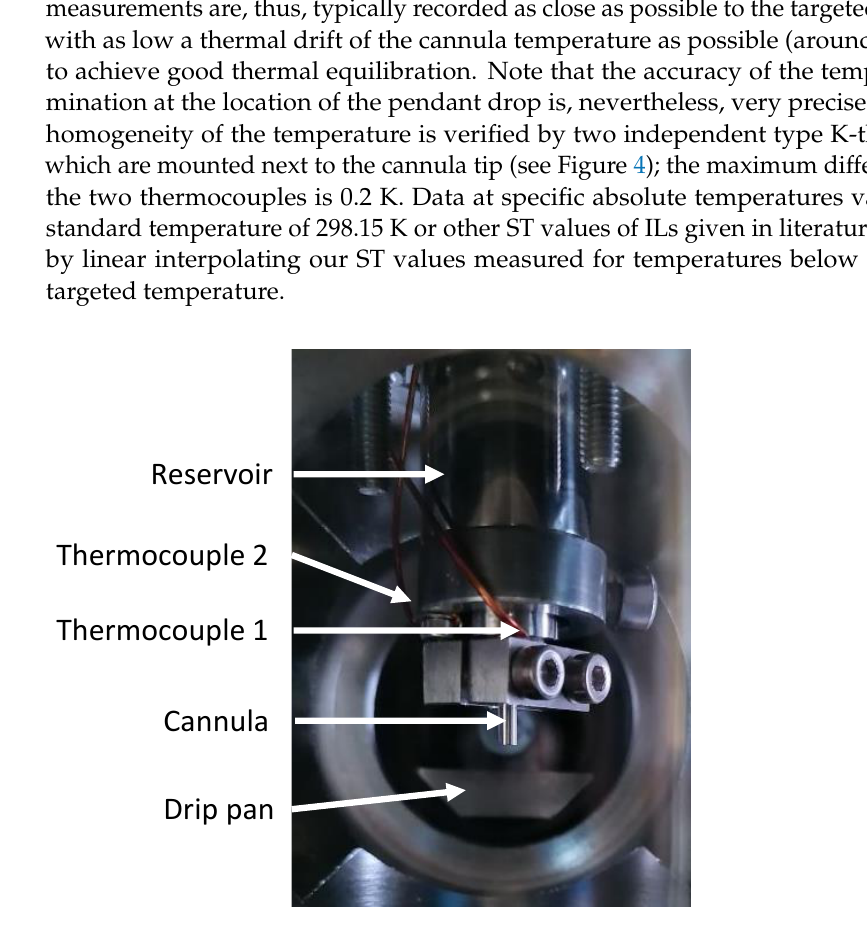
Figure 3. Left: Schematic representation of the PD setup with diffuse light source (left), chamber with drop (middle) and camera (right). Right: Drop image with manually set reference lines for surface tension evaluation (red, 1: magnification lines, 2: cannula end line, 3: boundary line for calibration) and obtained contour lines (turquoise).